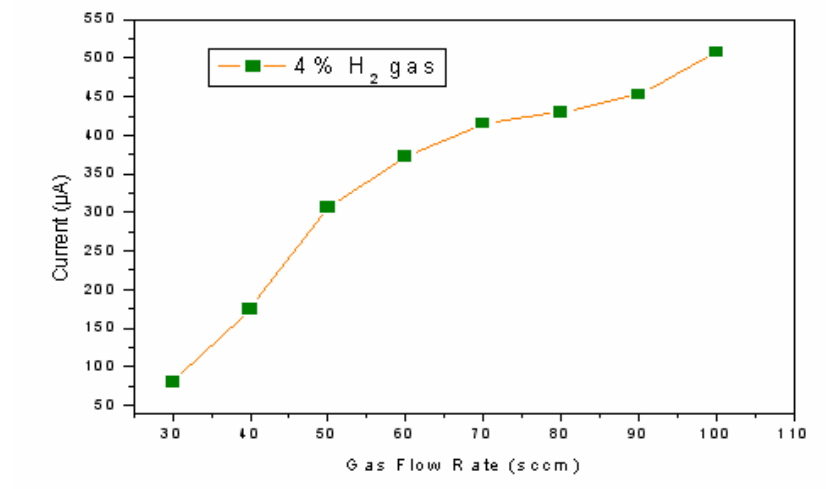
Figure 5. Variation of the output current for different flow rates at 4% H Nafion ® with an electrode area of 2 cm 2 prepared from 0.01 M Pt(NH (sample N1).